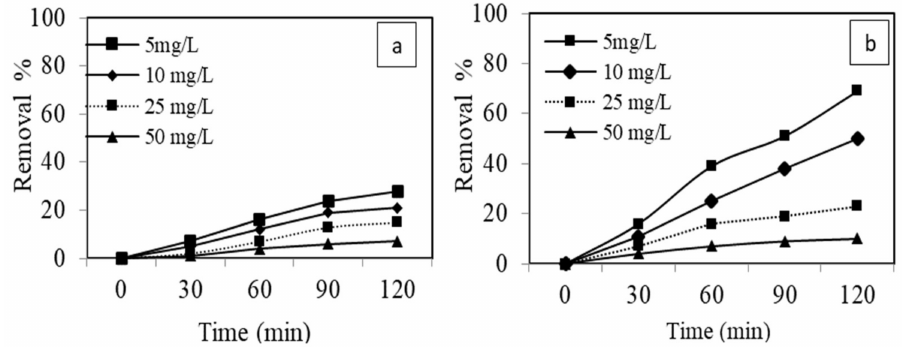
Figure 9. Effect of initial dye concentration on ( a ) adsorption and ( b ) sono-adsorption of (MB) using AgNPs.(AgNPs dosage = 0.005 g, pH = 6, US power = 80 W, and time = 120